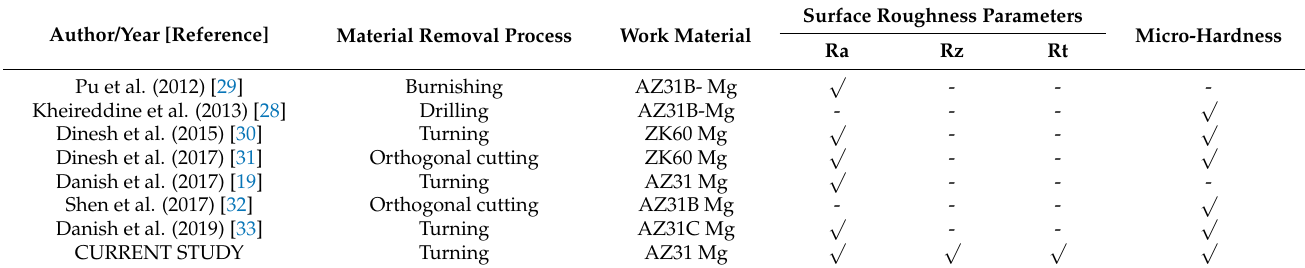
Table 1. Studies conducted on surface roughness and micro-hardness of magnesium alloys machined in a cryogenic environment.